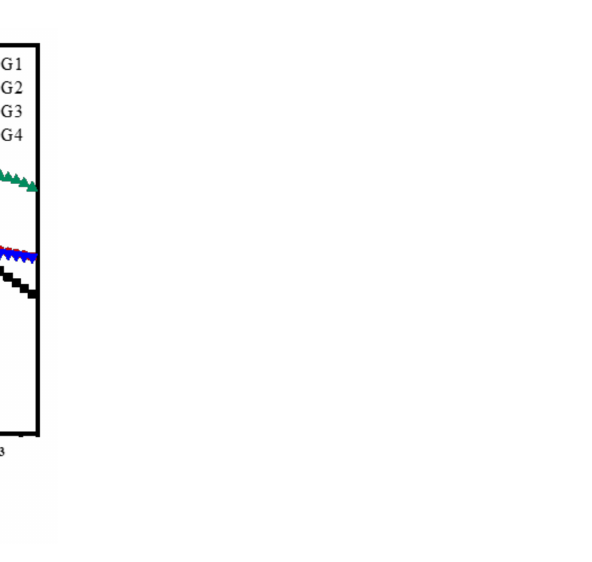
Figure 8. Each coating’s Bode pattern for immersion for 15 days: ( a ) 20% Seawater; ( b ) 40% Seawater; ( c ) 60% Seawater.